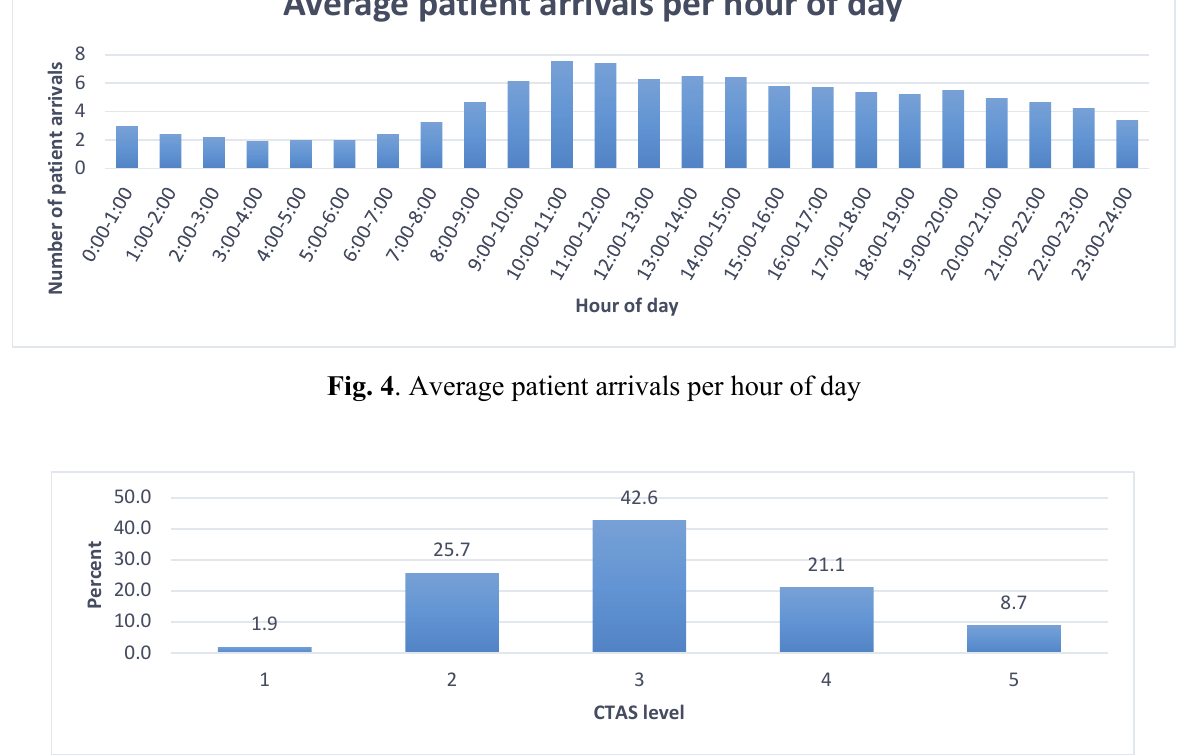
Fig. 5. The occurrence of CTAS 1 - 5 patients in the